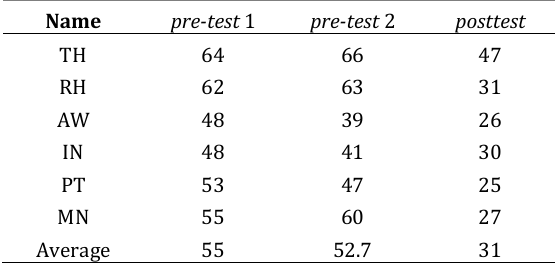
Table 3 Scores and averages of psychological burden scales